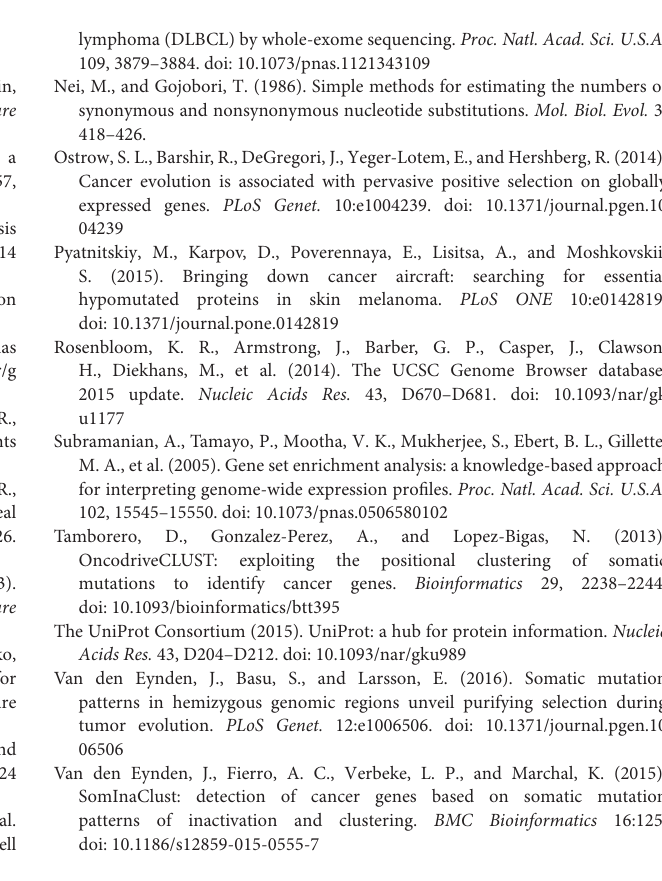
Table S1 | dN/dS ratios in 6 cancer types. The simple, 6-class corrected and 96-class corrected dN/dS metric was calculated for each gene that harbored at least 10 mutations. P -values are calculated using a one-tailed binomial test. Q -values are calculated using the Benjamini–Hochberg method. Cancer types are indicated by the tab names. Table S2 | GO gene set enrichment results on genes with low observed dN/dS values. A gene set enrichment analysis for GO and GO cellular components was performed on all genes that had dN/dS below 1 at 5% FDR in malignant melanoma (SKCM tab) and for the 100 genes with lowest p -values in each cancer type (indicated by tab names). GO terms are ranked based on increasing enrichment p -values. Table S3 | 6-class and 96-class mutational signatures for all cancer types. For each cancer type (row names) the proportions of the different substitution classes (column names) are given. Table S4 | Simulated dN/dS values in 6 cancer types. 6-class (first tab) and 96-class (second tab) mutational signature effect on dN/dS was simulated in 17,437 genes. The simulated dN/dS values were calculated by normalizing N